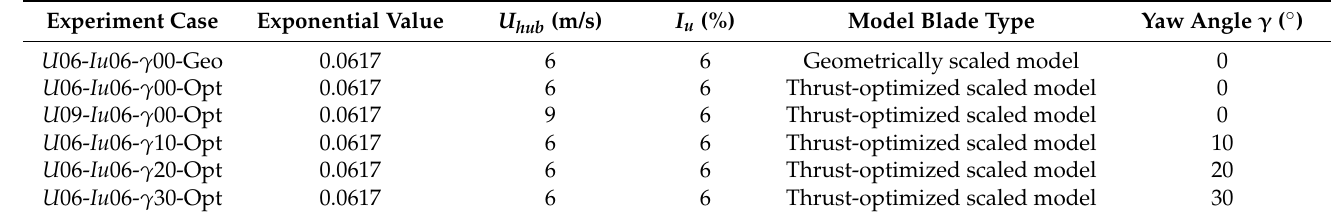
Figure 1. Experimental setup of scaled wind turbine in the wind tunnel test: ( a ) photo of passive devices for ABL flows; ( b ) scaled model of the wind turbine. Table 1. Experimental scenarios in this study. Table 2. Comparison of design parameters between scaled and full-scale wind turbine.